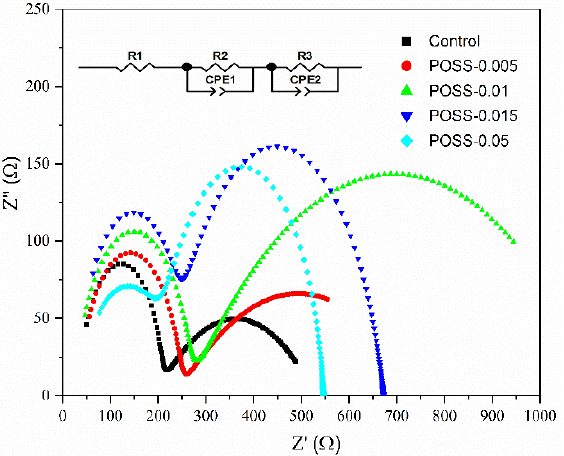
Figure 8. Nyquist plots of the electrochemical impedance spectra (EIS) of the control cell and the PSC fabricated with various POSS contents.